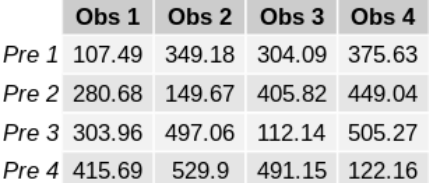
Oscillation (AO; Thompson and Wallace, 2000) are usually defined with EOFs. Biases in the representation of the NAO or the AO have been found to be typical in many CMIP5 models (Davini and Cagnazzo,